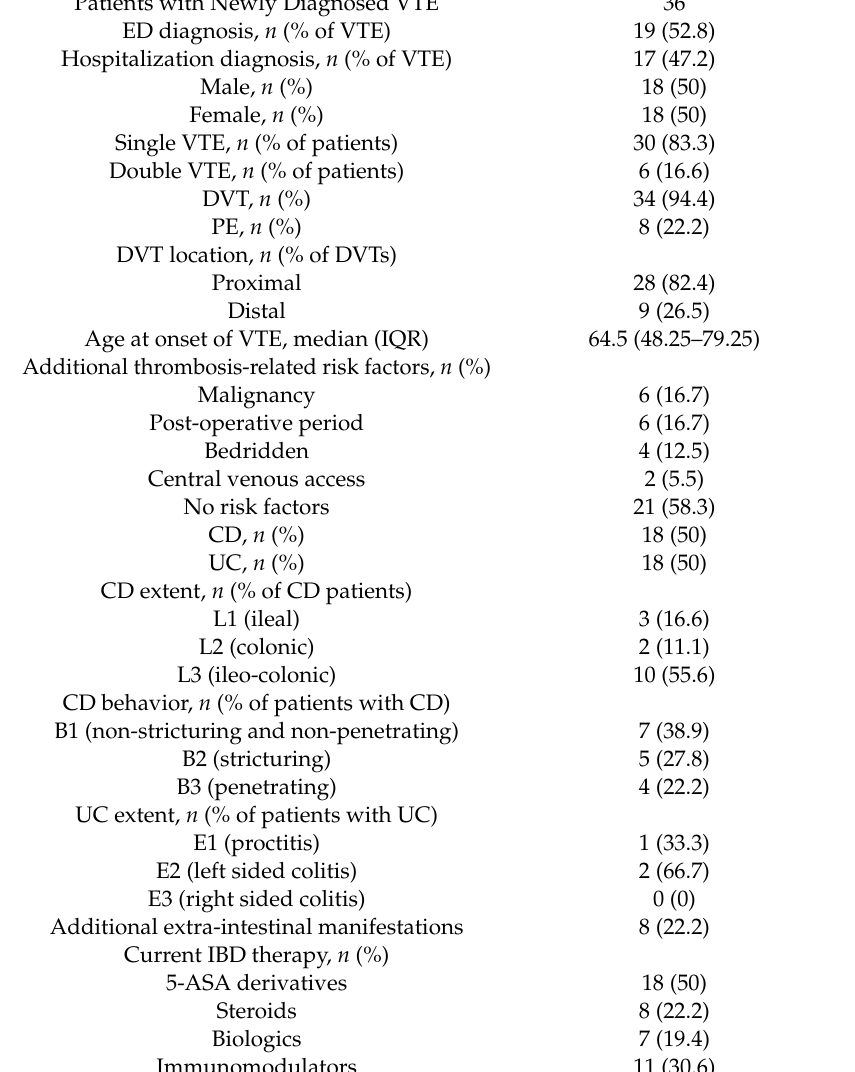
Table 2. Clinical characteristics of patients with IBD with newly diagnosed